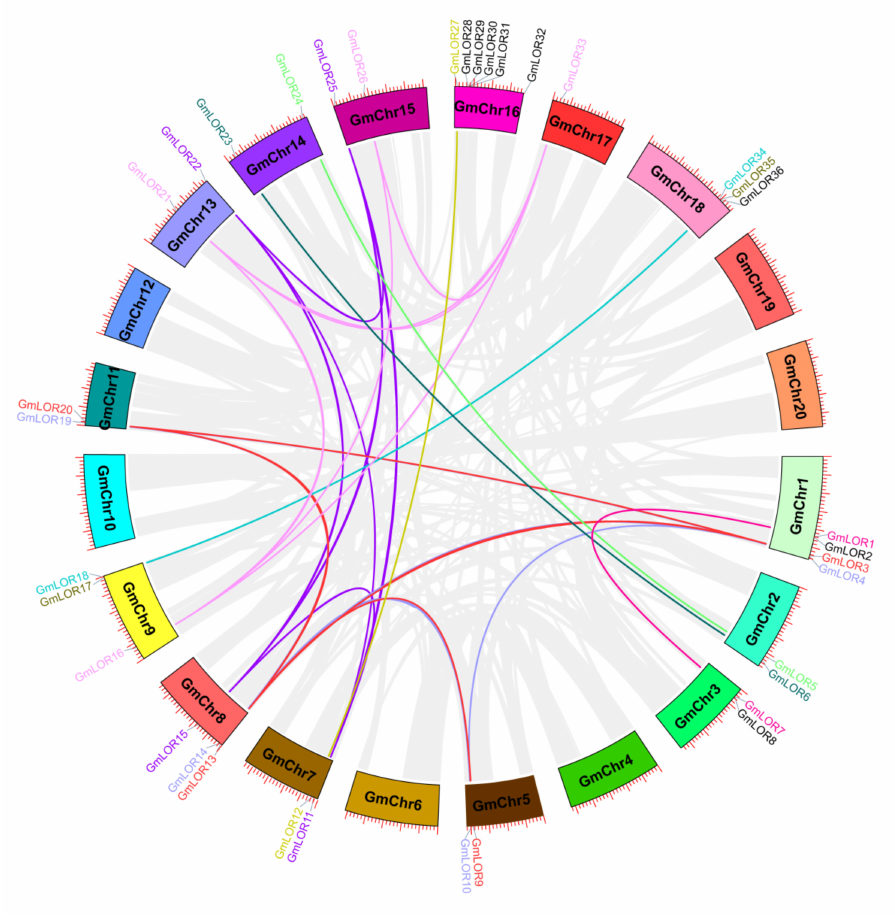
Figure 4. Distribution and synteny analysis of GmLOR genes. The soybean chromosomes are represented in different-colored partial circles. The different colored bars instruct LOR syntenic regions on the GmLOR gene family. The gray line represents other gene syntenic regions in the soybean